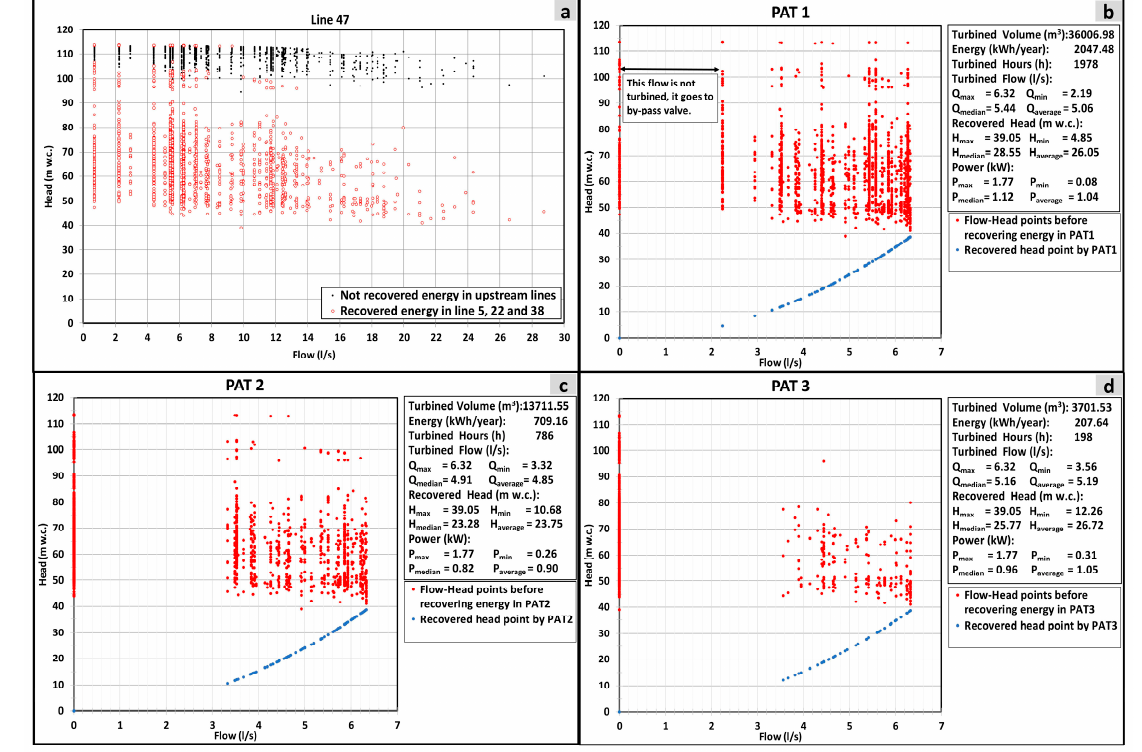
Figure 9. Results of the operation zone and parameters of the volumetric turbine flow.